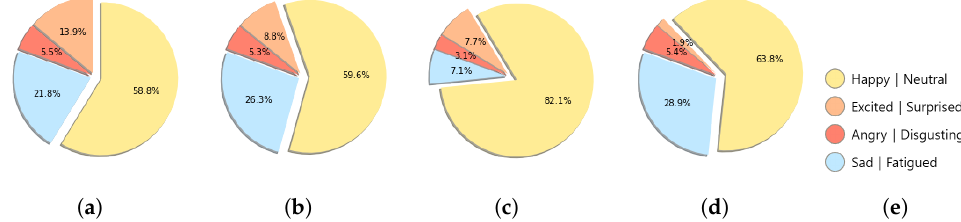
Figure 5. Pie charts for self-reported emotion label proportion by driver. ( a ) Driver A; ( b ) Driver B; ( c ) Driver C; ( d ) Driver D; ( e ) Legend of the pie